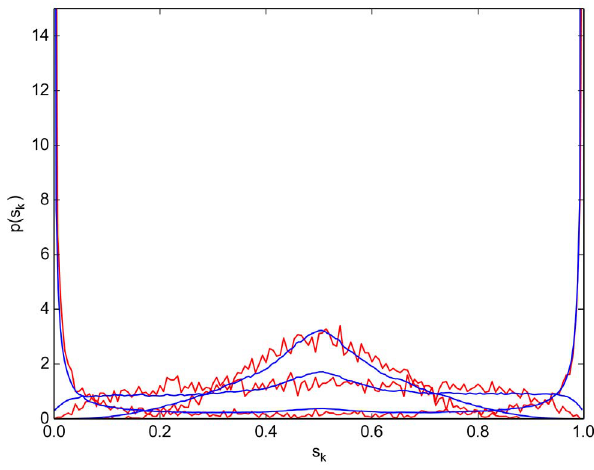
Figure 2. Probability density function. Probability density function p ( s , t ) as obtained from the microscopic simulation (red curve) and from the numerical integration of the FPE [Eq. (2)] (blue curve) at times t ~ 300 s, t ~ 500 s and t ~ 1000 s. The FPE coefficients were constructed from the microscopic simulation of the virtual swarm (cf. Fig. 1).